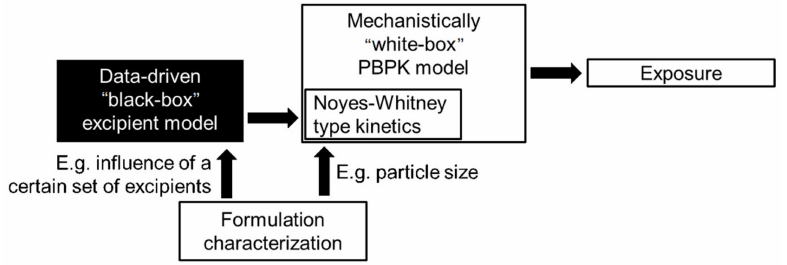
Figure 15. Exemplary model structure to integrate unknown excipients influence to the dissolu- tion